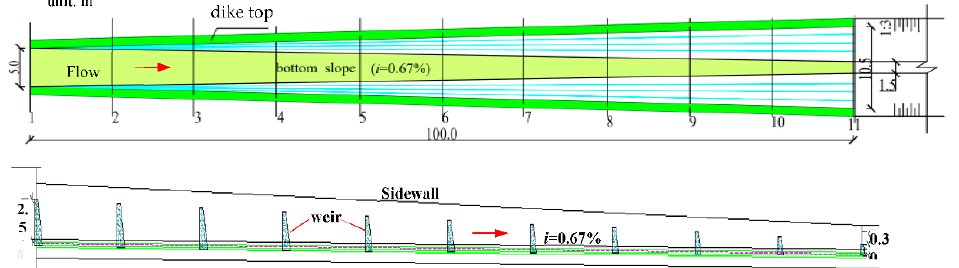
Figure 6. Layout of the transition reach and multistage weirs (1–11). The transition reach is a non- prismatic channel in which the bottom width was designed as decreasing along the longitudinal direction while the side slope increases accordingly. The cross-section of the entrance is a rectangle, while that of the export is a trapezoid. There are eleven weirs, and their heights decrease along the flow direction, which causes water depth to diminish correspondingly.